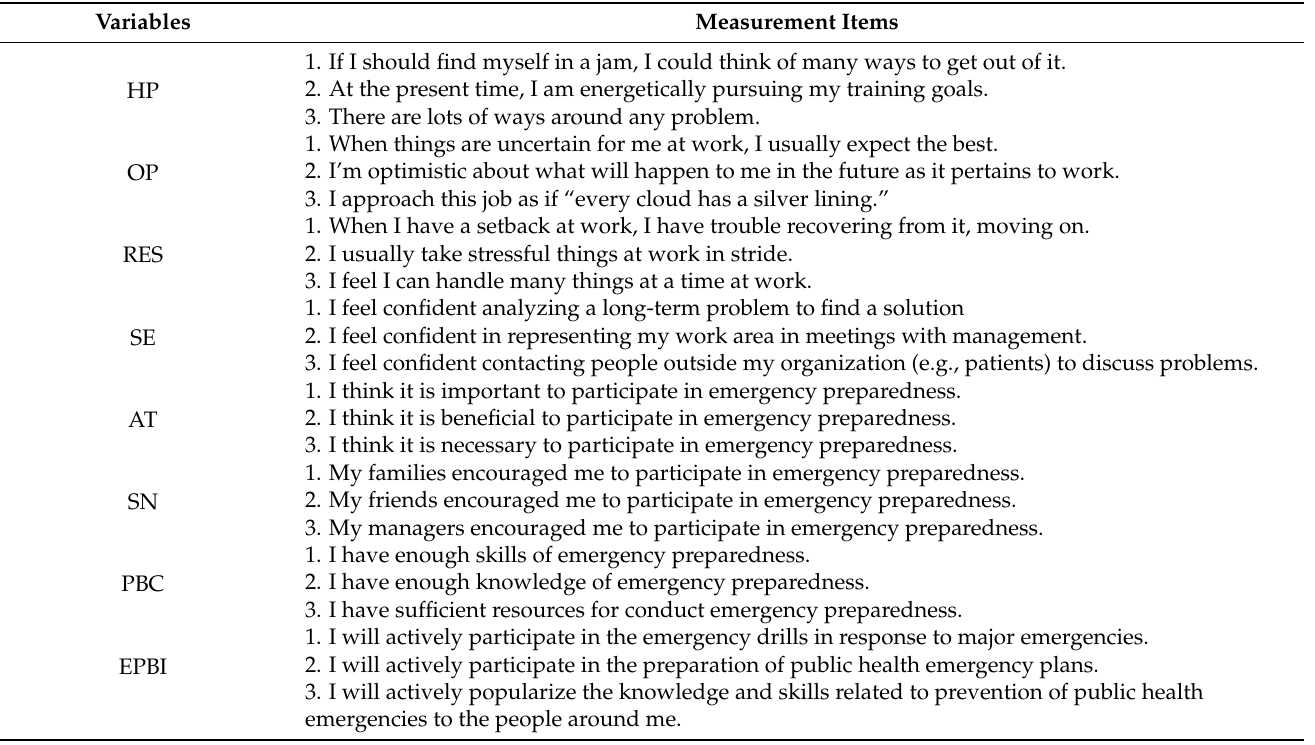
Table 1. Measurement items of latent variables.